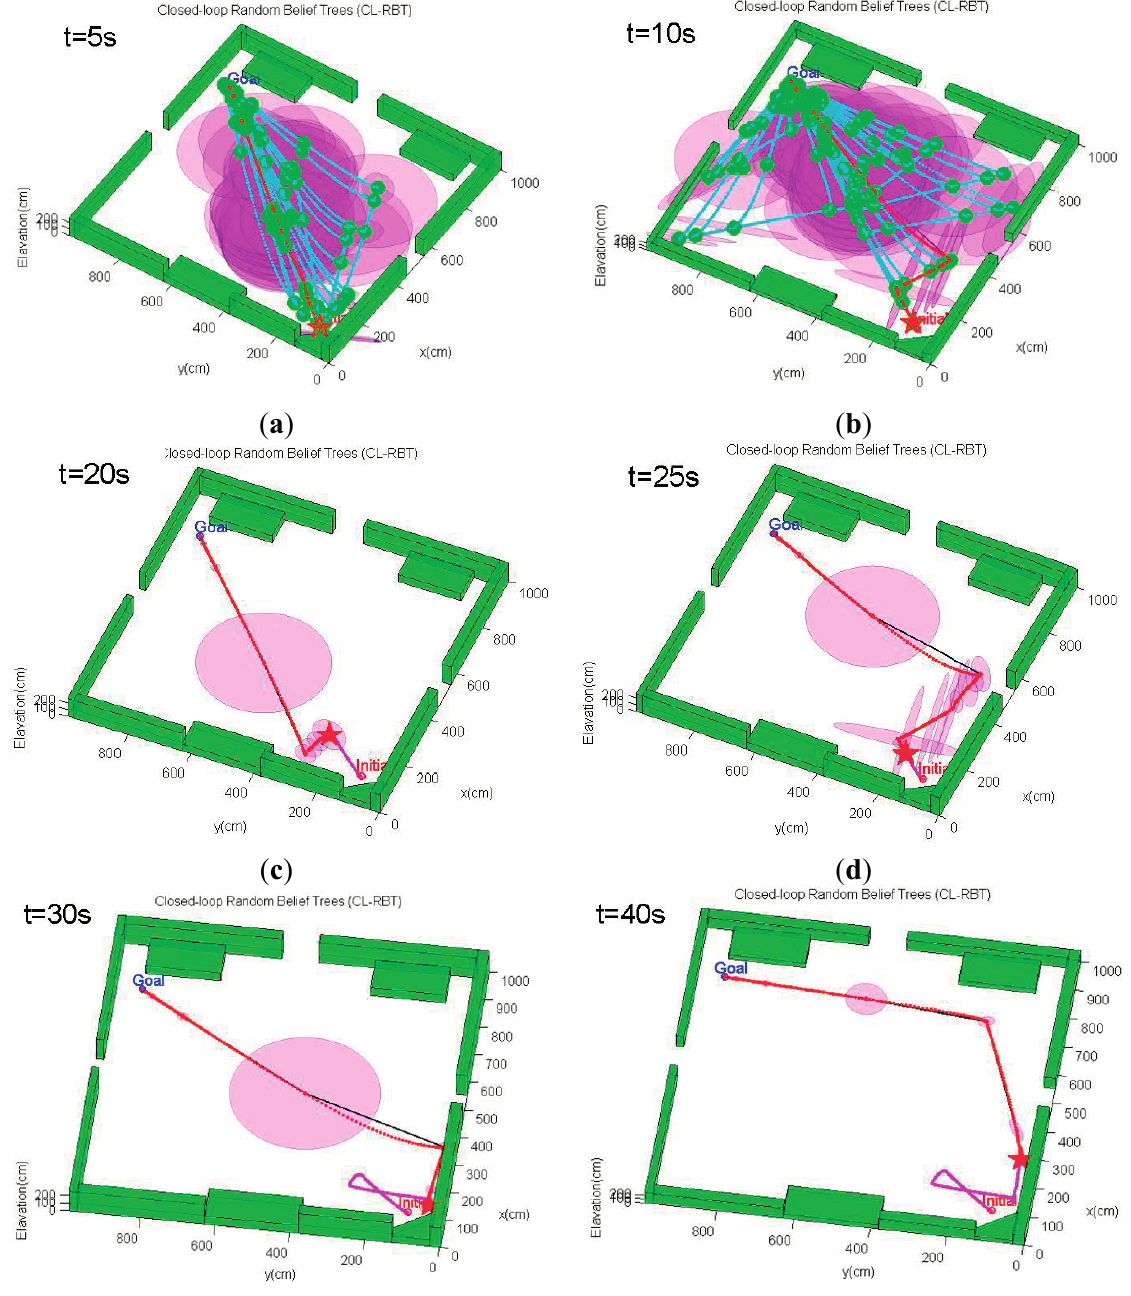
Figure 8. Example results of trajectory generated by CL-RBT for a quadrotor MAV navigating in simulation Scenario 1. The pink ellipses represent the covariance of the position estimate, and large ellipses denote MAV states with high uncertainty. The current state (MAV’s 3D positions and headings) is denoted with a red pentacle. The current selected path (specified by node sequence, used as the reference to the control system) is marked in black with red dots representing the nodes. The predicted closed-loop trajectory corresponding to the current selected node sequence is emphasized in red, while the actual output trajectory flown by the closed-loop MAV model is marked in pink. The current tree is denoted by green nodes and cyan trajectories, but is set as invisible after ( b ) for clarity. ( a ) t = 5 s; ( b ) t = 10